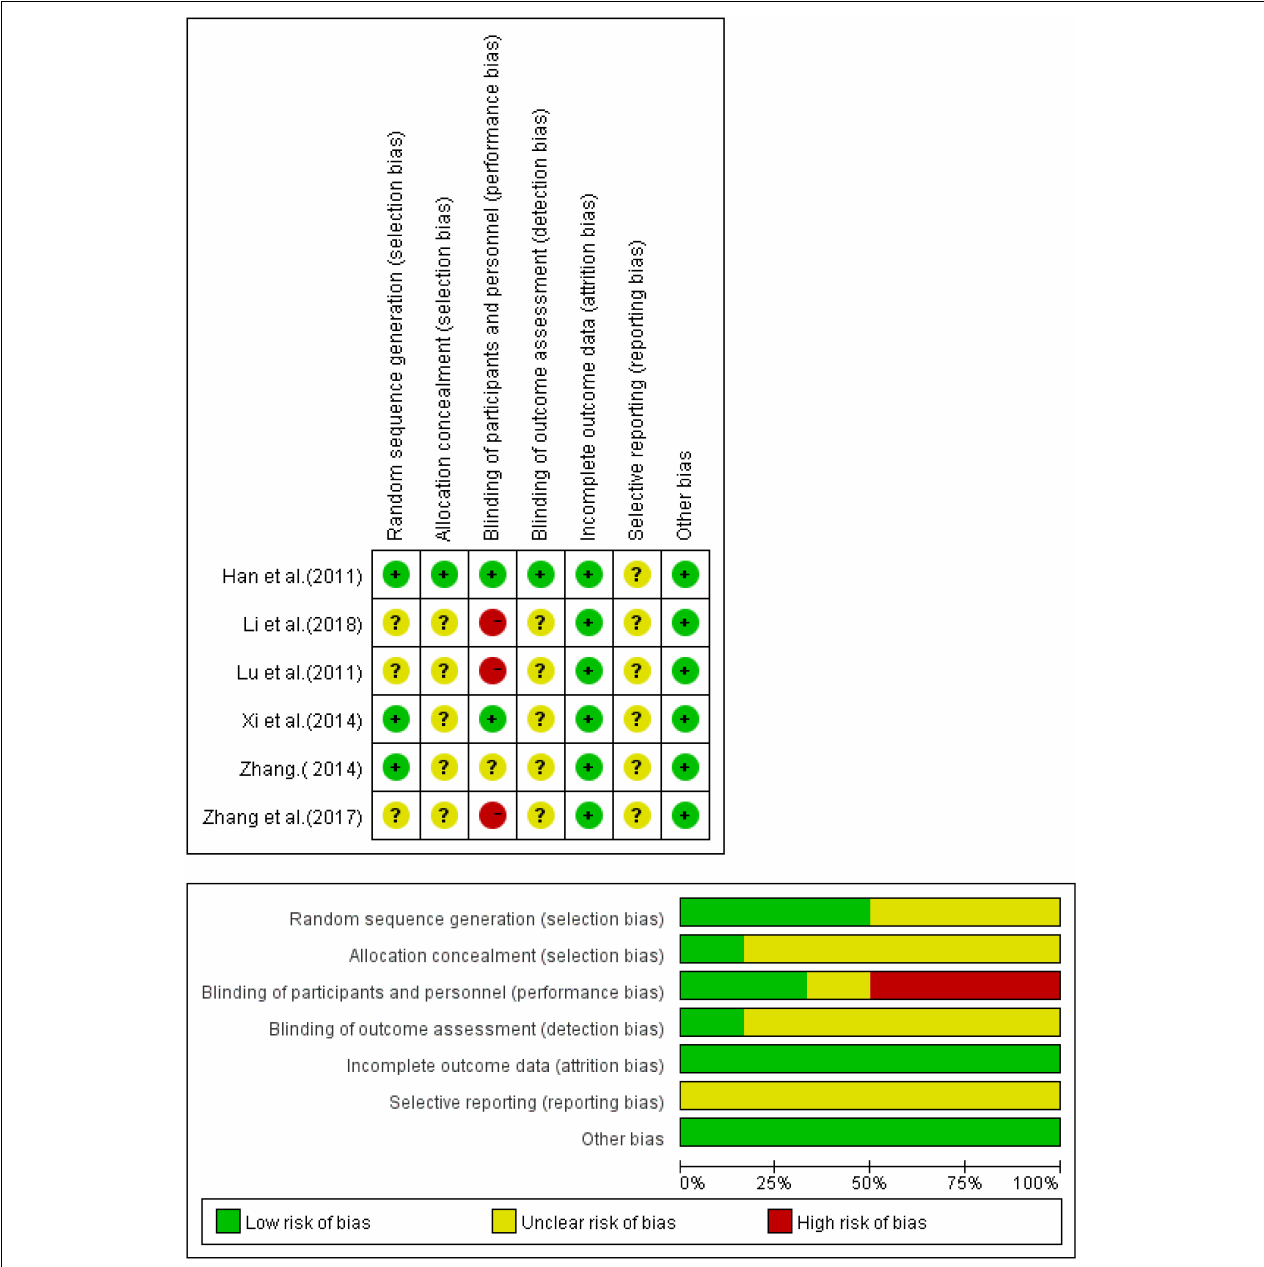
FIGURE 3 | Assessment of the risk of bias of CHM vs. western medicine